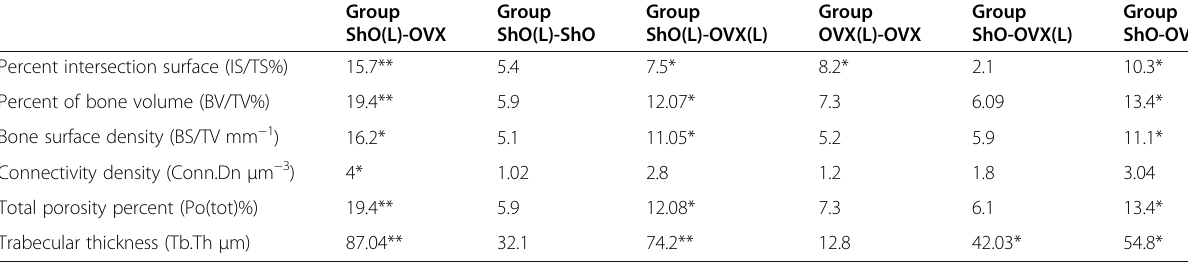
Group ShO(L)-OVX